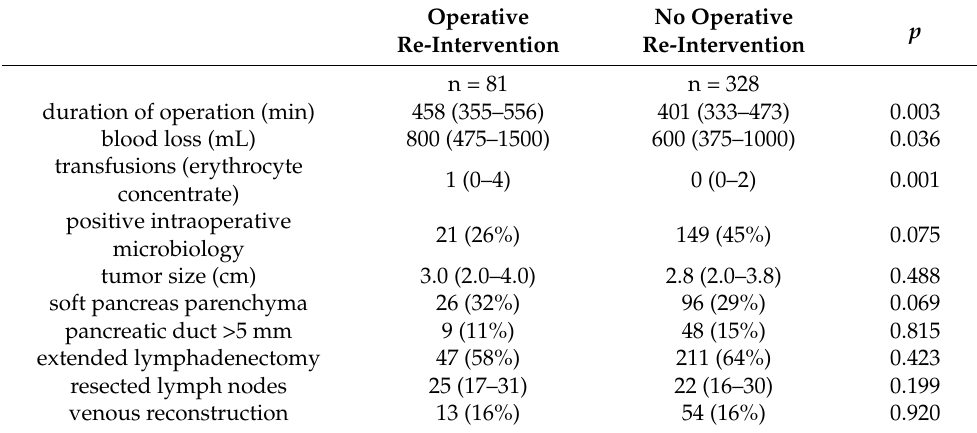
Table 2. Perioperative data of index operation.